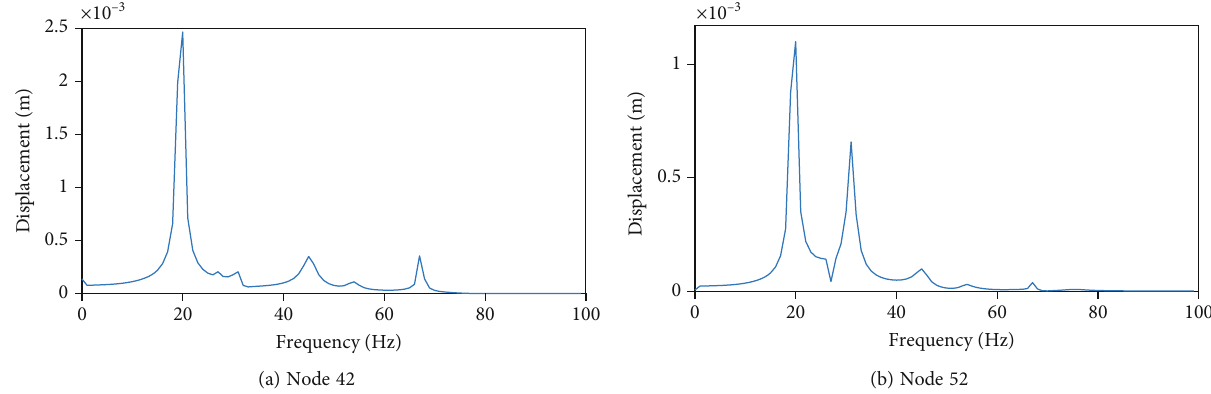
Figure 14: Response frequency analysis of suspension point.